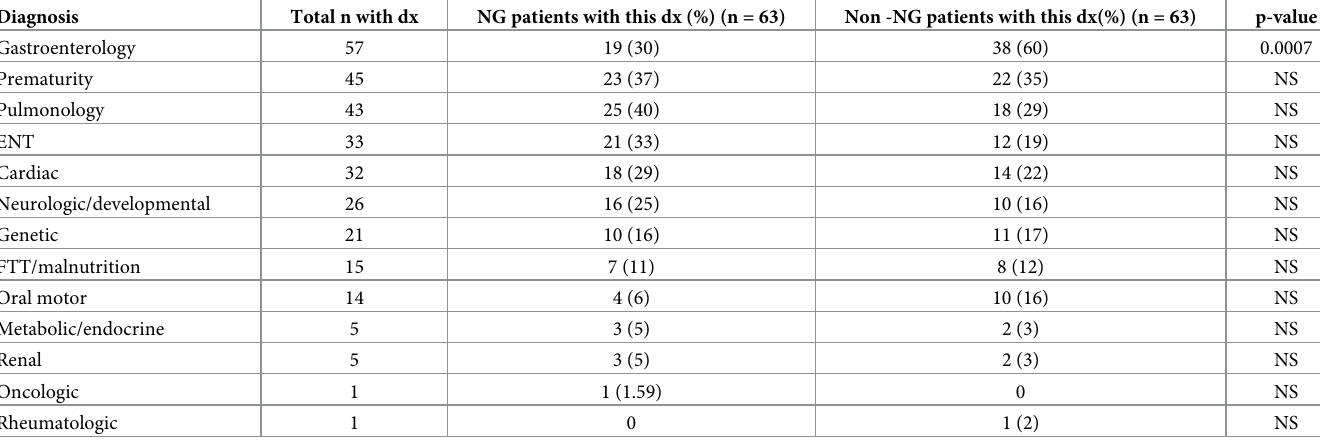
Table 3. Diagnoses at time of videofluoroscopic swallow study.